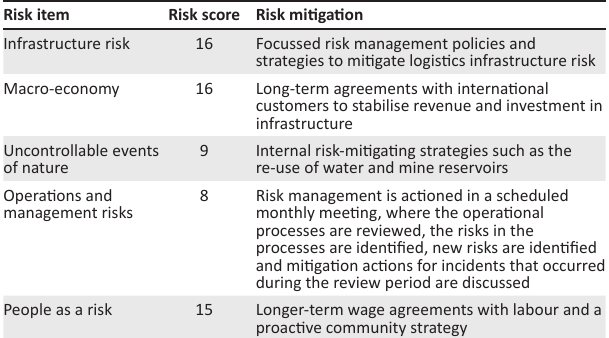
TABLE 3: Summary of risk scores and mitigation. Risk